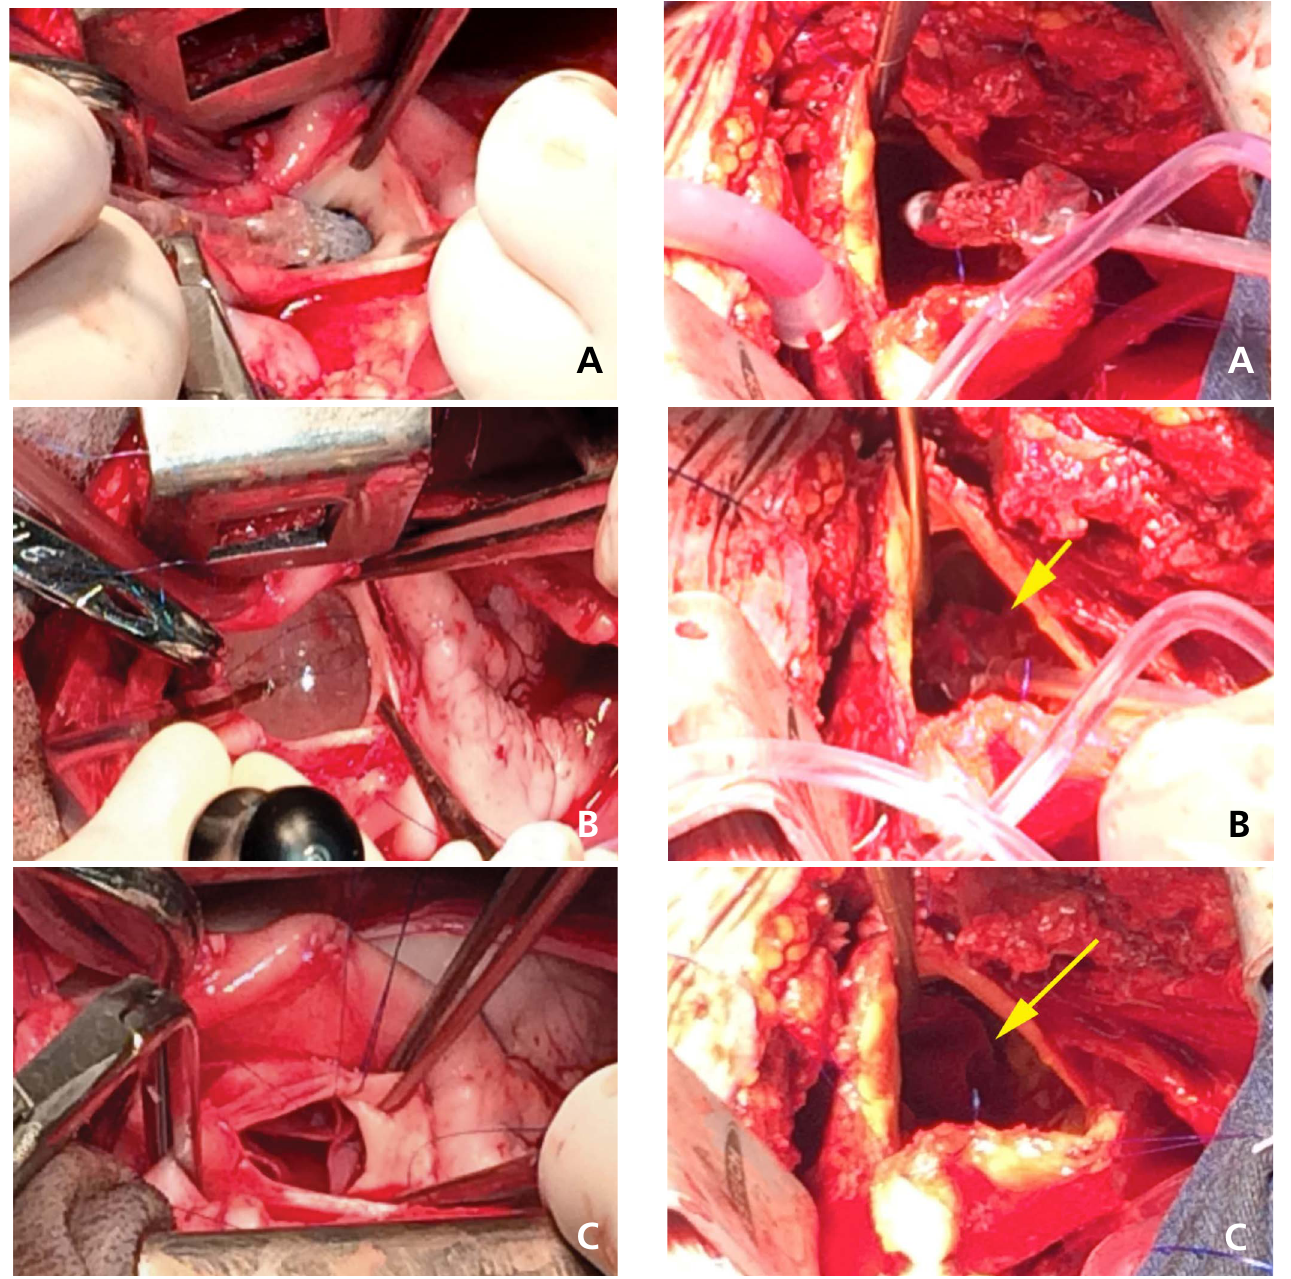
Fig. 3 - The clinical case. A=transverse aortotomy and insertion of the catheter-mounted valve. B=balloon expansion of the prosthesis. C=prosthesis deployed to the aortic annulus with 1/3 of the structure on the left ventricular